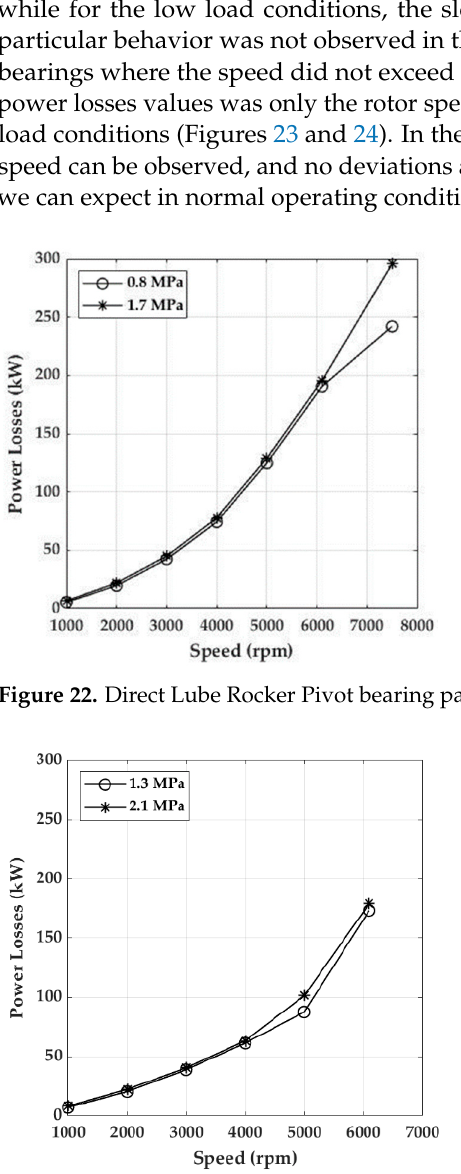
Figure 24. Flooded Ball & Socket Pivot bearing pad power losses.